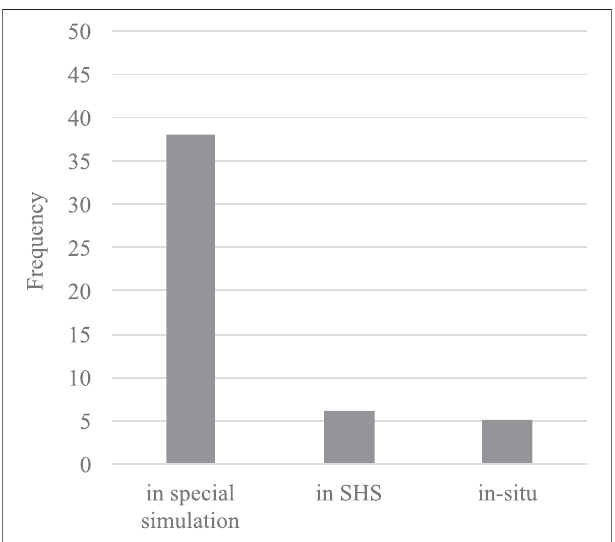
FIGURE 3 | Bar chart of validation platforms for the proposed collision avoidance algorithms.